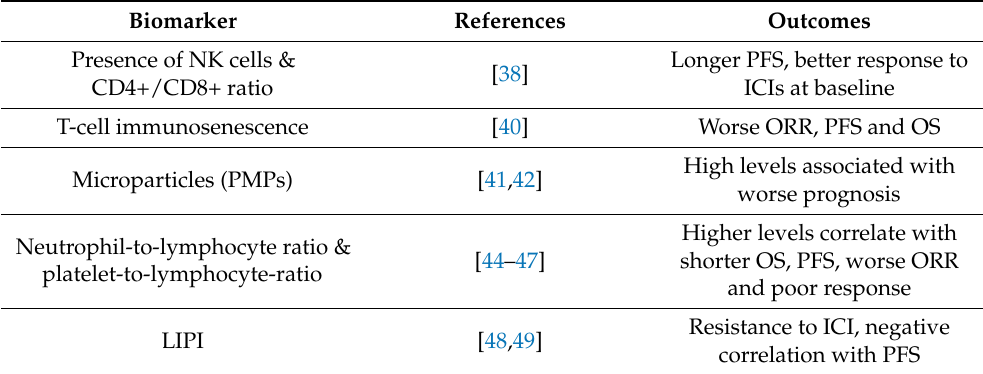
Table 2. Circulating immune cells studies assessing different immune cell-related biomarkers for ICI response prediction and their association with clinical